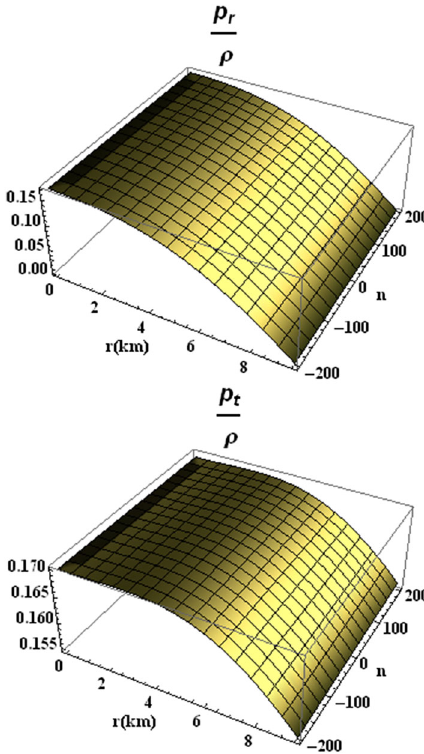
Fig. 3 (Top) In this figure, along x -axis, y -axis and z -axis we have respectively plotted the radius of the star in km unit, the dimensionless quantity n which lies in the range − 200 ≤ n ≤ 200 and the ratio of radial pressure p r to the matter density ρ which is a dimensionless quantity. (bottom) along x -axis, y -axis and z -axis we have respectively plotted the radius of the star in km unit, the dimensionless quantity n which lies in the range − 200 ≤ n ≤ 200 and the ratio of transverse pressure p t to the matter density ρ which is a dimensionless quantity. Both the profiles are drawn for a compact star of mass M = 1 . 85 M (cid:3) and radius of the star=9 . 5km by fixing b = 0 . 0095 km − 1